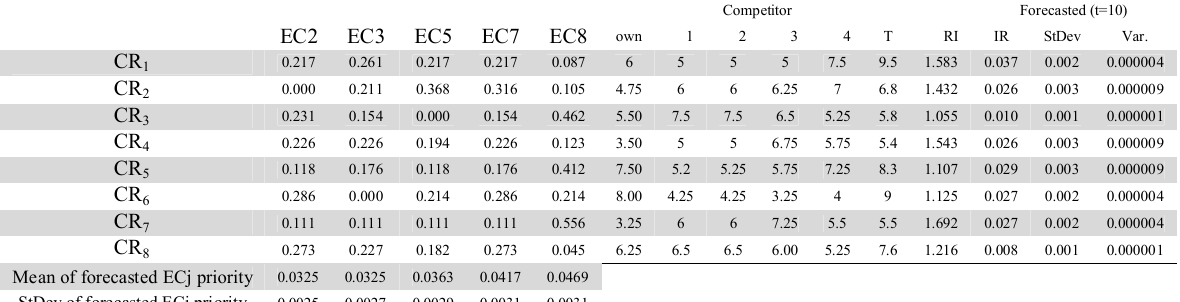
Fig. 8. The DQFD for Alternator